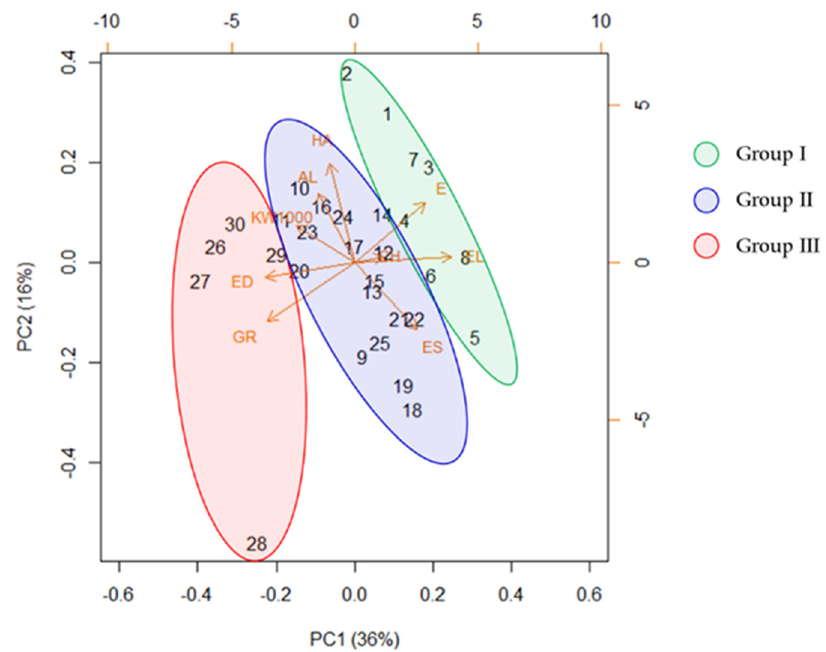
Figure 5. Principal Component Analysis (PCA) of morpho-agronomic traits in 30 tetraploid wheats. Colored ellipses represent the groups identified in the phylogenetic analysis. Genotypes are numbered from 1 to 30: PAO-02 (1), PAO-01 (2),BB-02 (3), BB-03 (4), BB-04 (5), BRL-03 (6), BIV-03 (7), BRL-01 (8), BIV-04 (9), BNC-01 (10), BNC-02 (11), BNL-01 (12), BNL-02 (13), BNL-04 (14), BC-01 (15), BS-01 (16), BT-01 (17), CIC-02 (18), CIC-03 (19), BS-02 (20), BNL-05 (21), BNL-03 (22), BG-03 (23), BF-01 (24), CIC-01 (25), BIDI-03 (26), SIM (27), CAP-8 (28), BRCb-01 (29), BRCa-01 (30). Traits associated with sample discrimination are indicated in the plot: habitus (HA), time of earing (E), culm height (CH), ear length (EL), awns length (AL), ear shape (ES), ear density (ED), 1000-kernel weight (KW1000).